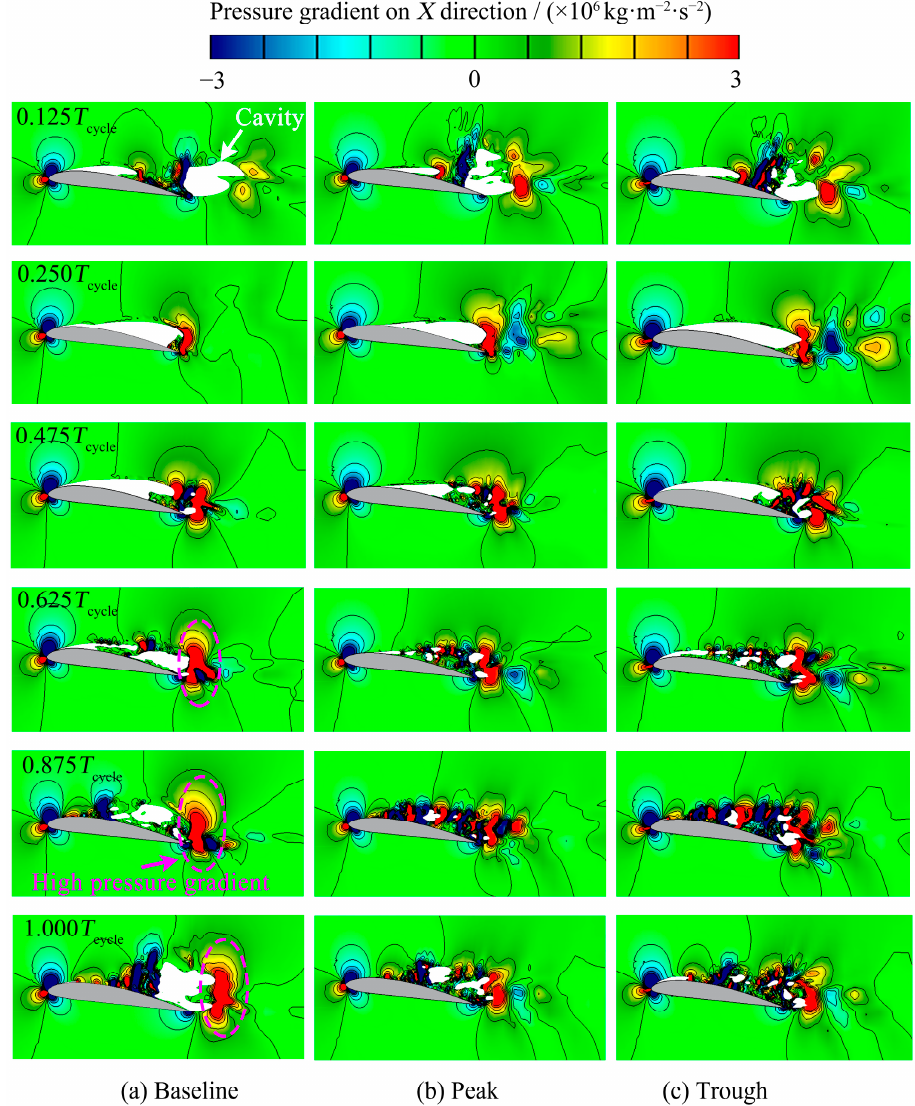
Figure 10. Pressure gradient and cavity shape contours for the mid-span of the baseline hydrofoil ( a ), the sections of the peak ( b ) and the trough ( c ) of the Type Ⅰ .